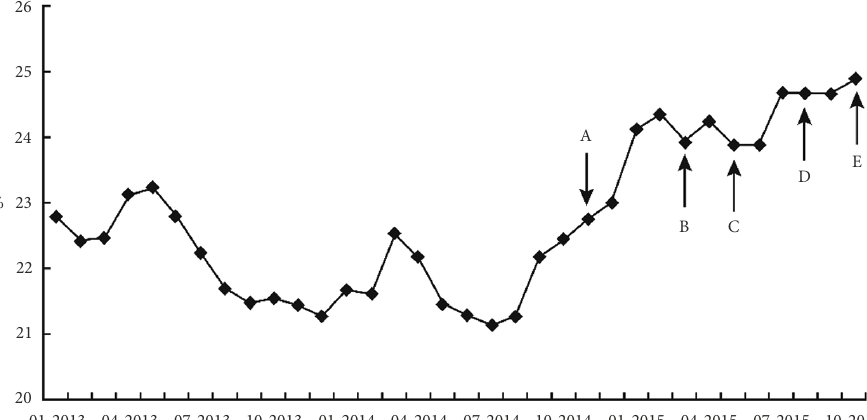
Figure 2. Inflation – adjusted aggregate private lending rates in Wenzhou, China (monthly